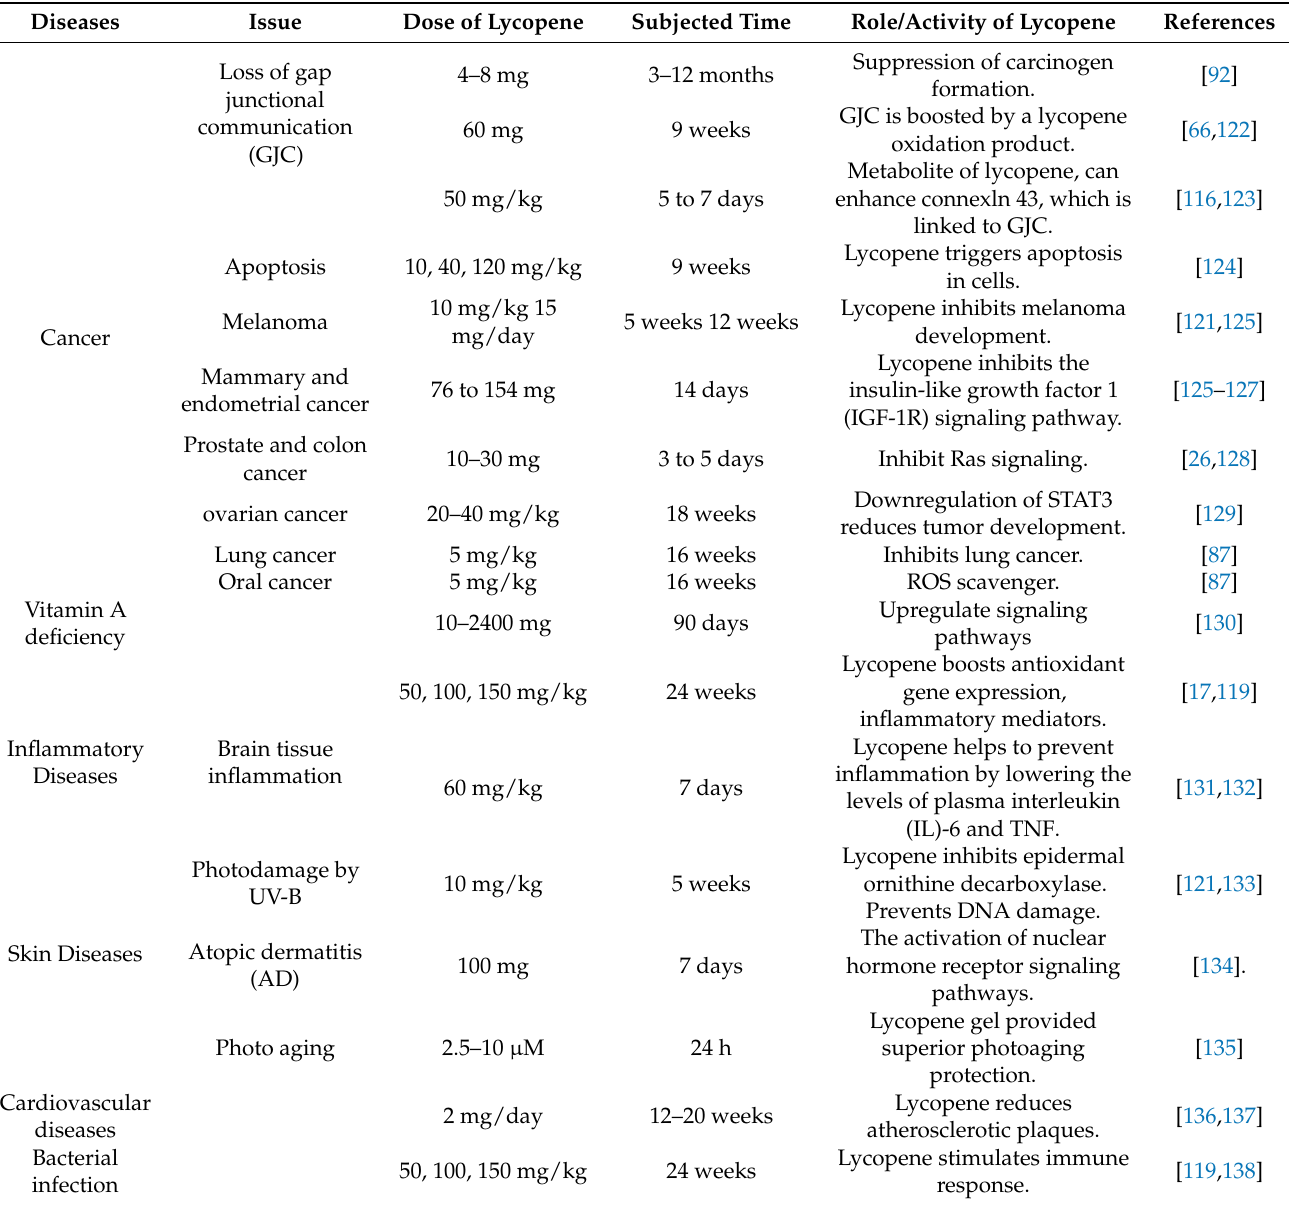
Table 1. An illustration of the nutraceutical impact of lycopene against